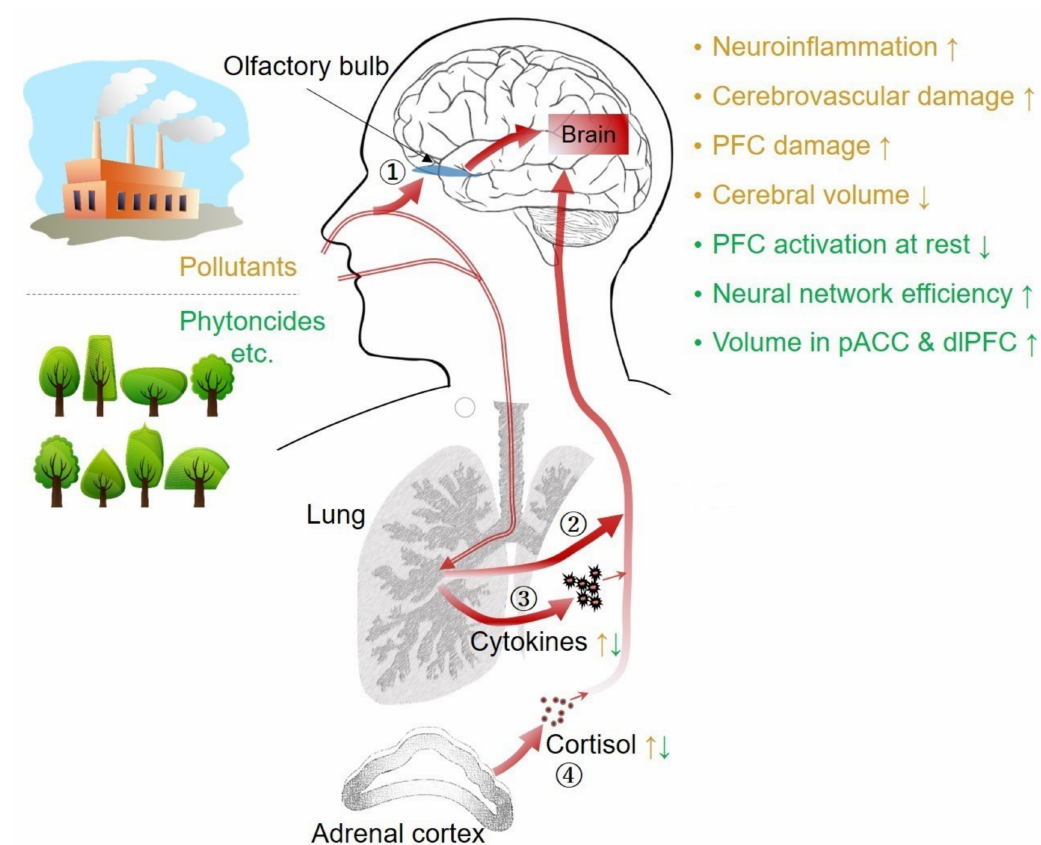
Figure 1. Air pollution and greenspace’s multiple pathways to the brain. Once inhaled, pollutant particles can enter the brain directly via the nasal olfactory pathway 1 (cid:13) or indirectly through the circulatory system after they penetrate the lung tissue 2 (cid:13) . They cause inflammation in the nose and lungs and release pro-inflammatory cytokines into the circulation 3 (cid:13) . In addition, they activate the hypothalamus–pituitary–adrenal (HPA) axis and increase the blood levels of stress hormones, including cortisol 4 (cid:13) . Both pro-inflammatory cytokines and cortisol can reach the brain. Greenspace produces phytoncides and other health-promoting chemicals such as negative air ions, which affect the brain through similar pathways but in the opposite direction. For a more comprehensive review of the pathways, see